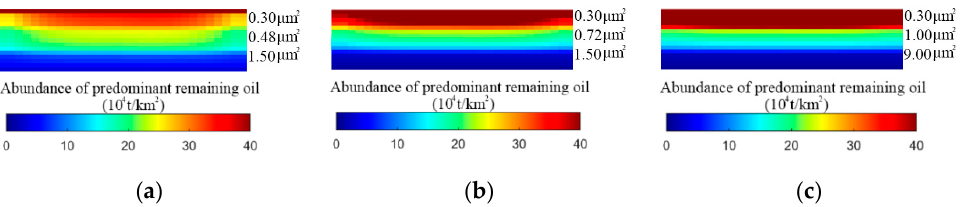
Figure 8. Abundance of predominant remaining oil under different permeability contrasts. ( a ) PC = 5; ( b ) PC = 15; ( c ) PC = 30.